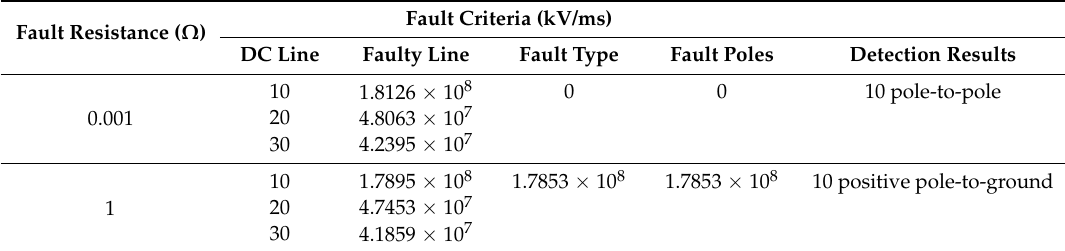
Table 2. Detection results of DC faults.